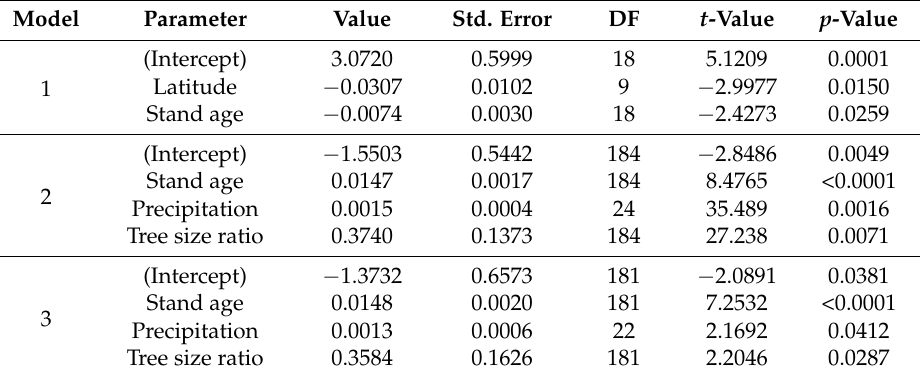
Table 5. Three linear mixed-effects models that related different site variables (e.g., annual precipitation) and stand characteristics (e.g., stand age, ratio of mean diameter of pine to spruce trees in the mixture) of each measurement period and site to the productivity ratio ME between mixed stands and the average of the corresponding monocultures. While Model 1 excludes study sites without monospecific spruce, others include estimated growth of spruce based on yield tables. Model 3 included the initial mixture proportion of spruce at the beginning of the measurement